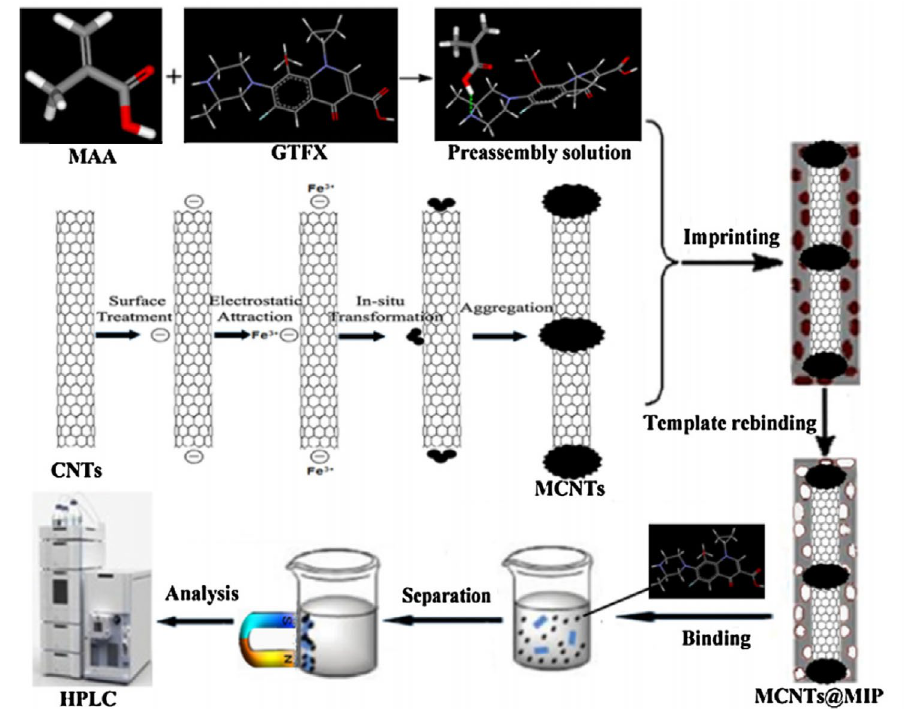
Fig. 8. Scheme of the synthetic route for MCNTs@MIP and their application for SPE of GTFX with the help of an applied magnetic field [44].